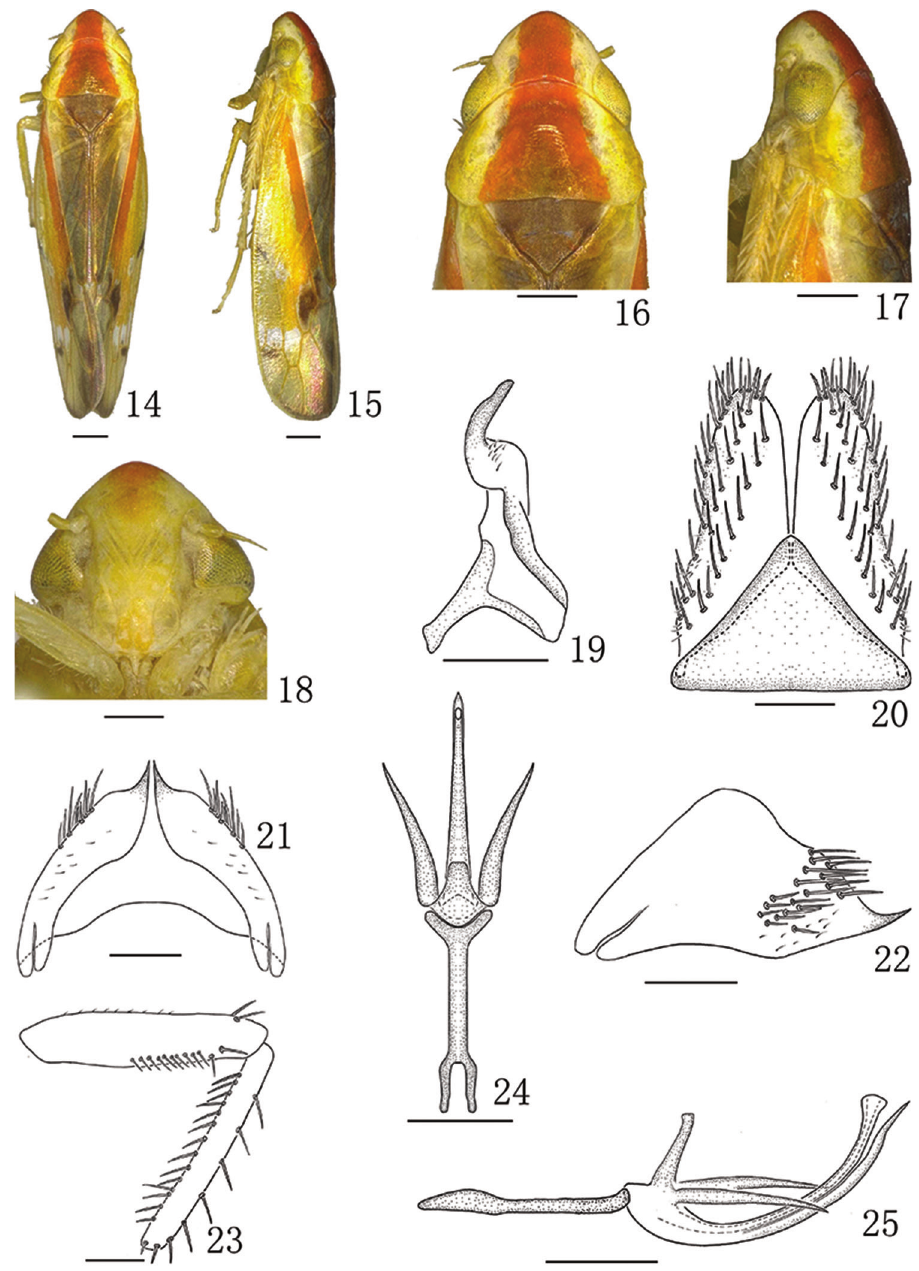
dorsal view 20 Valve and subgenital plate, ventral view 21 Male pygofer, ventral view 22 Male pygofer, lateral view 23 Fore femur and tibia, anterior surface 24 Connective and aedeagus, dorsal view 25 Con- nective and aedeagus, lateral view. Scale bars: 0.5 mm ( 14–18 ); 0.2 mm ( 19–25